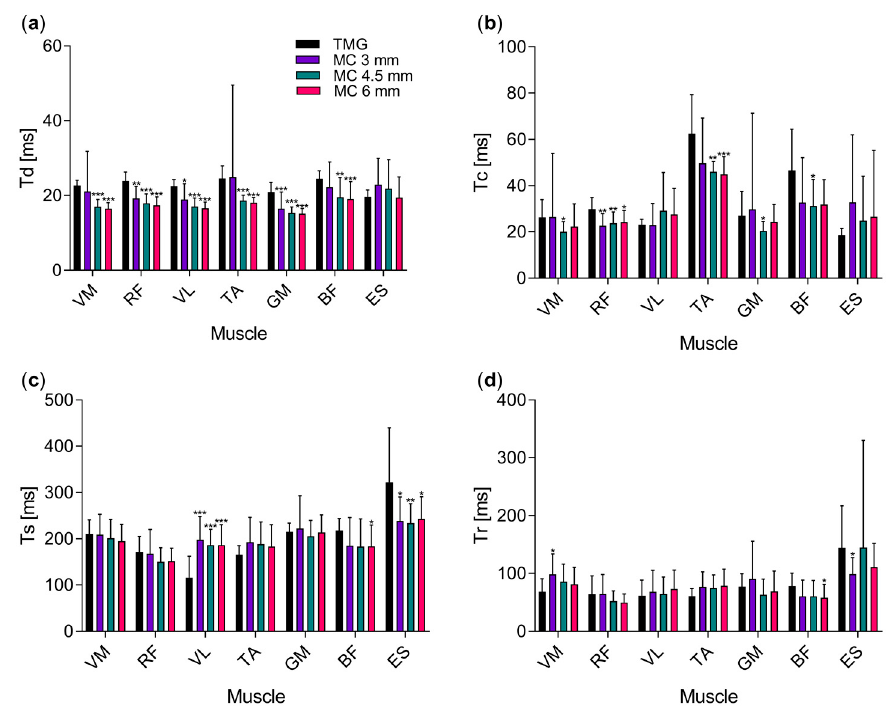
Figure 4. Comparison of four di ff erent temporal parameters extracted from responses of muscle belly to electrical stimulus, measured with TMG and MC. ( a ) Delay time, Td; ( b ) contraction time, Tc; ( c ) sustain time, Ts ( d ) relaxation time, Tr. Measurements with TMG are compared to those with MC sensor at three di ff erent depths (3, 4.5 and 6 mm). Asterisks indicate the level of statistical significance (* P < 0.05, ** P < 0.01, *** P < 0.001). Mean values and standard deviations are shown.